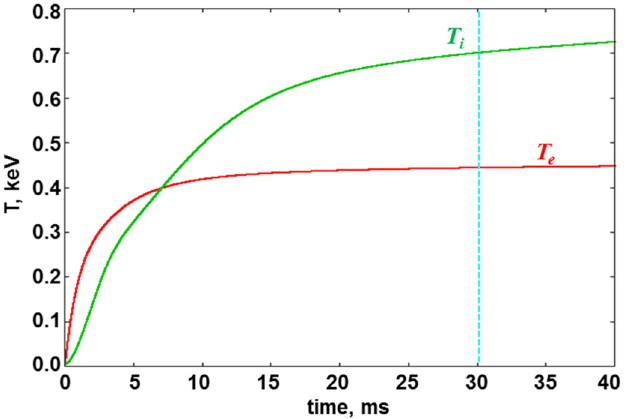
Figure 3. Simulated electron ( T e ) and ion ( T i ) temperatures in GDT ‐ U vs. time after NBI is switched